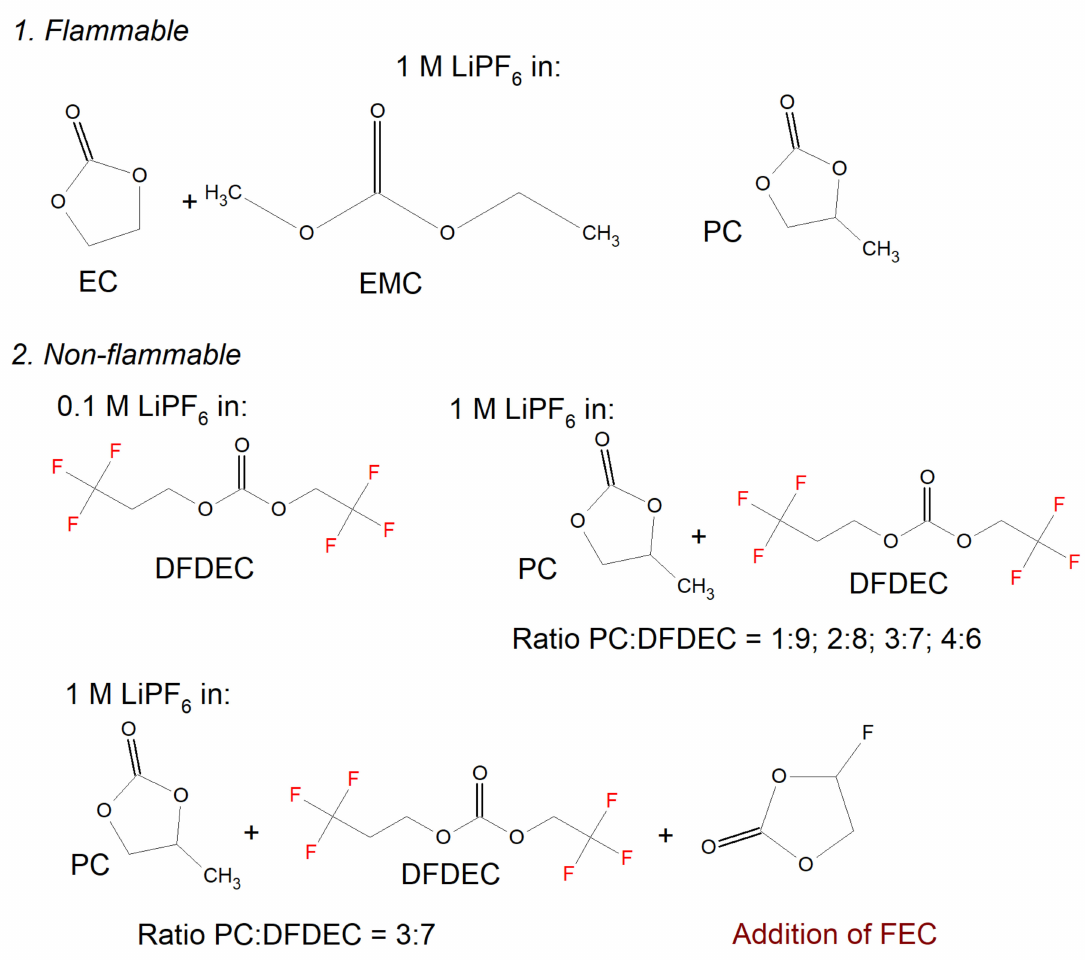
Figure 8. Flammability test results for ( 1 ) LiPF 6 /EC conventional electrolytes: DMC (ratio 3:7 vol); 1 M LiPF 6 /PC; ( 2 ) 0.1 M LiPF 6 /DFDEC; 1 M LiPF 6 /PC: DFDEC in volumetric ratios of 1:9, 2:8, 3:7, 4:6; 1 M LiPF 6 /PC: DFDEC (3:7) with an addition of 1 wt.%